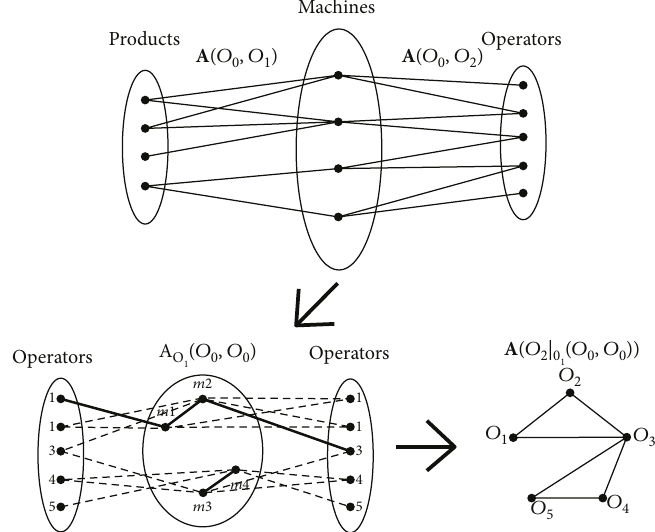
Figure 4: The advantage of complex conditional analysis using inner